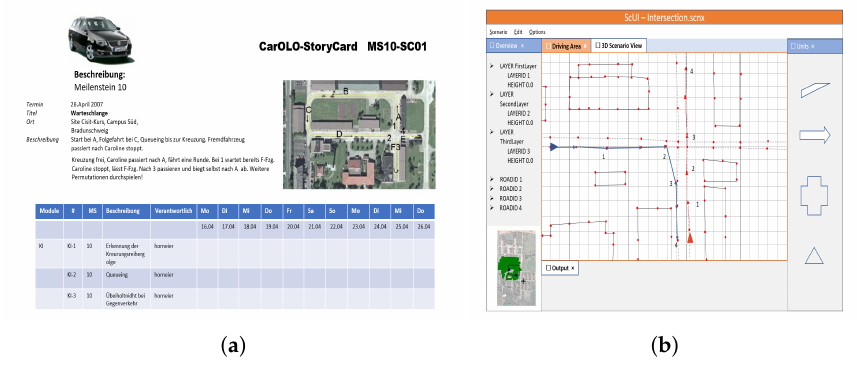
Figure 5. Hesperia framework scenario description [29]. ( a ) Story Card by project CarOLO. ( b ) Graph- ical Editor for using DSL.